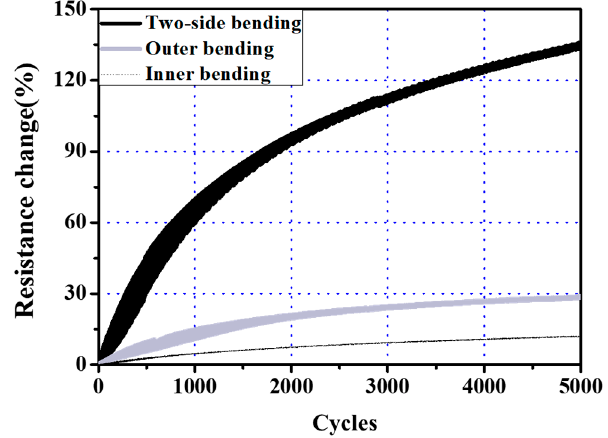
Figure 12. Change in resistance of RFID sample under three different bending loads.